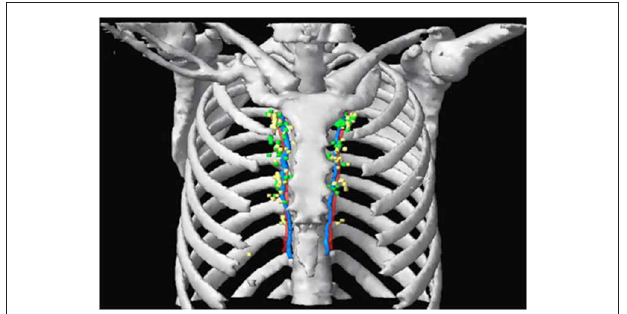
FIGURE 3 | SPECT/CT fused with CT image showing IM-SLN distribution in different intercostal spaces. Green and yellow nodes indicate solitary IMNs and multiple IMNs, respectively. Red and blue indicate IM artery and IM vein.